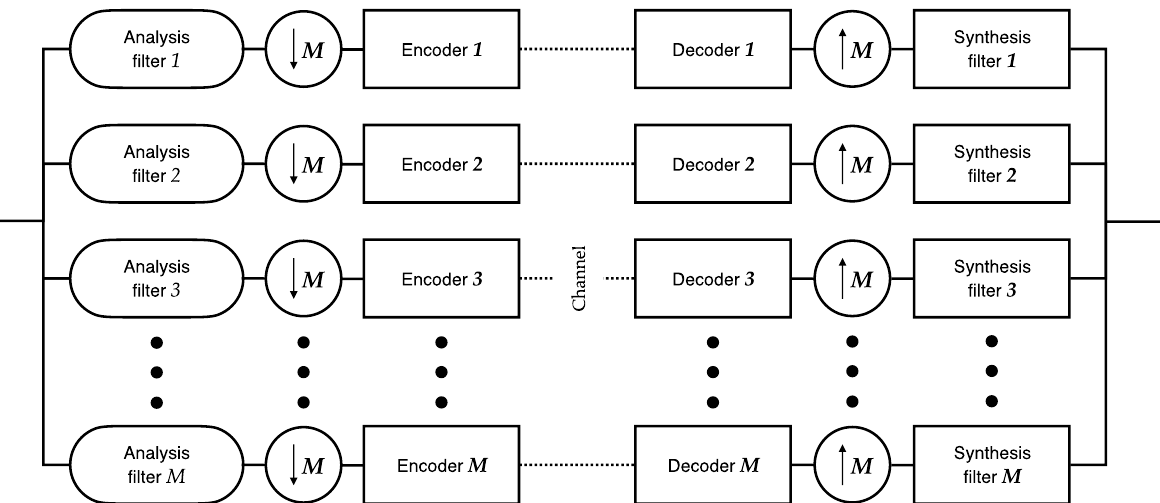
Fig. 6 Sub-band coder with M equal-bandwidth filters; the output of each filter in the encoder is downsampled M:1 and then upsampled 1:M in the decoder. In each channel, the analysis and synthesis filters are the